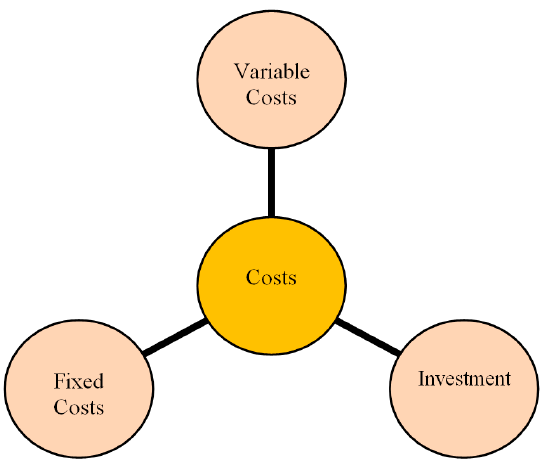
Figure 8. Classification Costs for system operators are subdivided into three major categories [78].